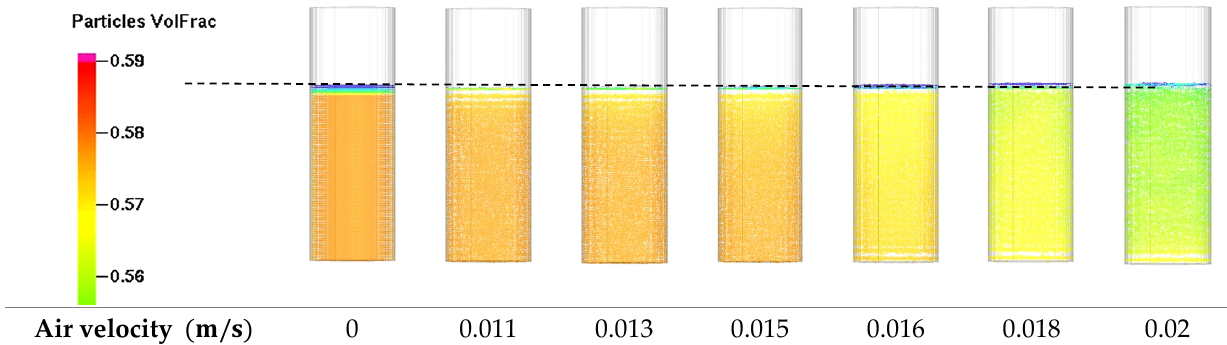
volume diameter (diameter of a sphere having the same volume as the particle) and the other symbols represent the same parameters as discussed in the previous equations.